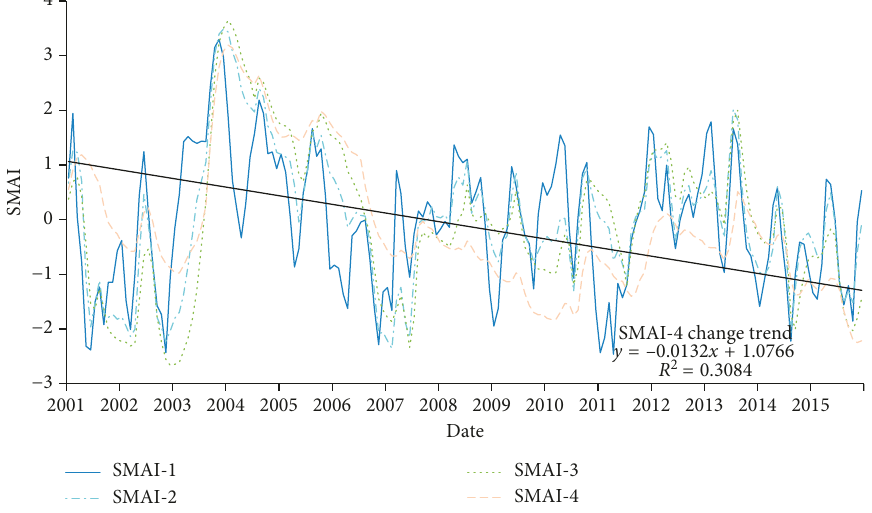
Figure 2: Monthly time series of the average SMAI in North China.